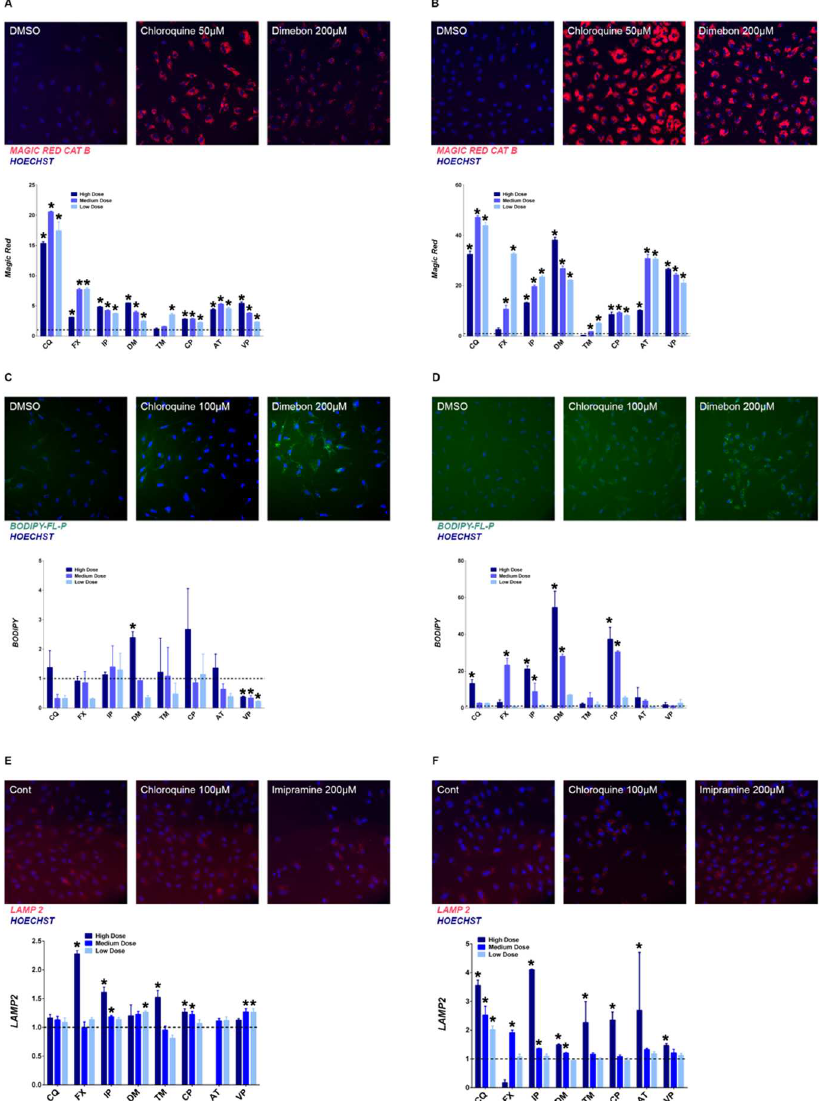
Fig 2. Increaseof cathepsin B and D activity, and LAMP2 staining. Representative images for Cathepsin B activity (magic red staining)after 4 hrs (A) or 24 hrs (B), CathepsinD activity (Bodipy-FL-P) after 4 hrs (C)